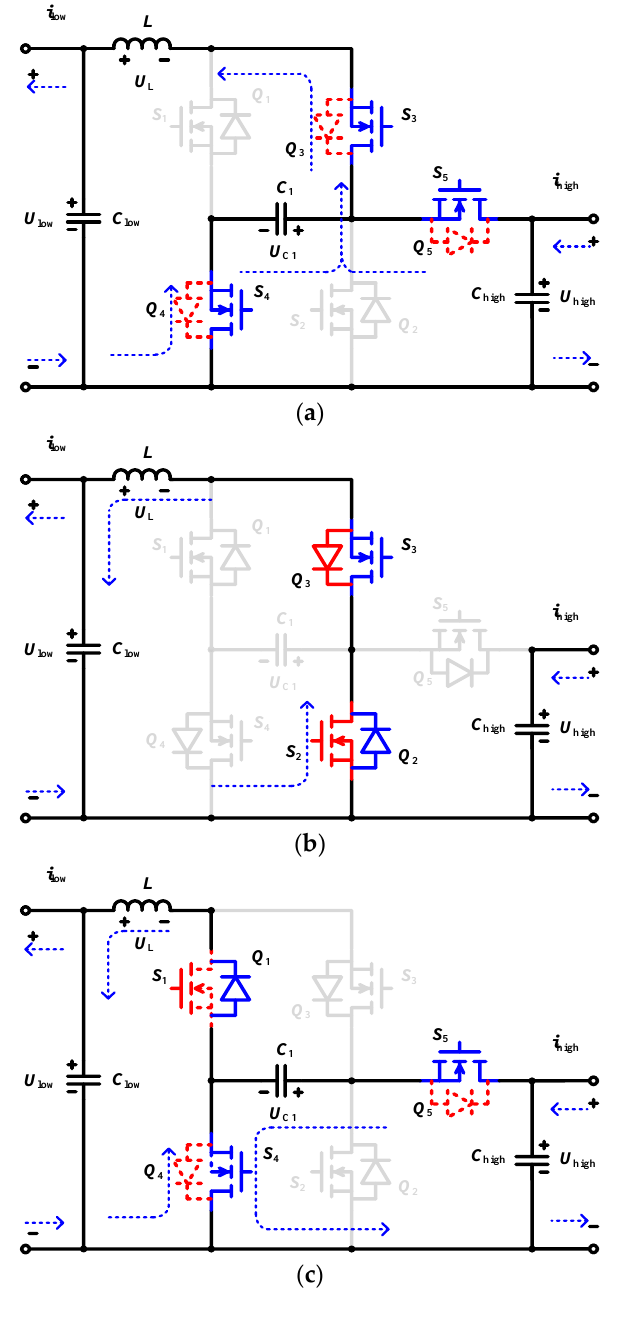
Figure 5. Energy flow paths of the proposed converter in the step-down mode; ( a ) S 3 S 4 S 5 = 111; ( b ) S 3 S 4 S 5 = 100; ( c ) S 3 S 4 S 5 = 011.